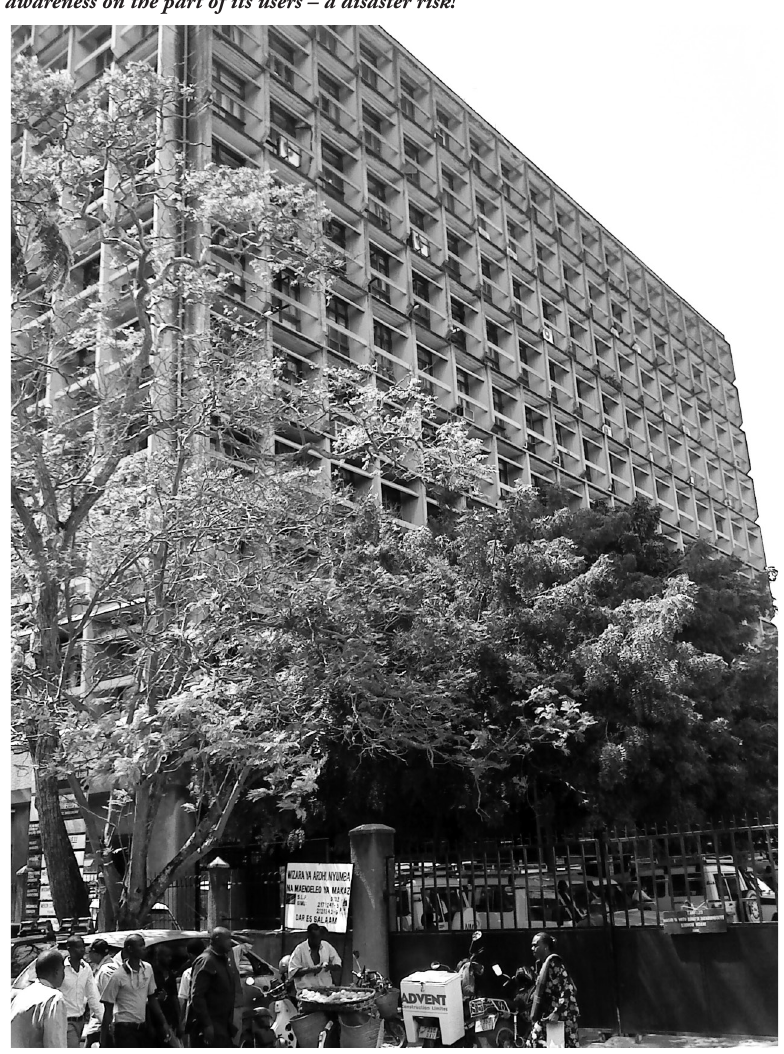
Fig 2. Ardhi House – one of the buildings poorly equipped with fire fighting means and facilities, in addition to limited awareness on the part of its users – a disaster